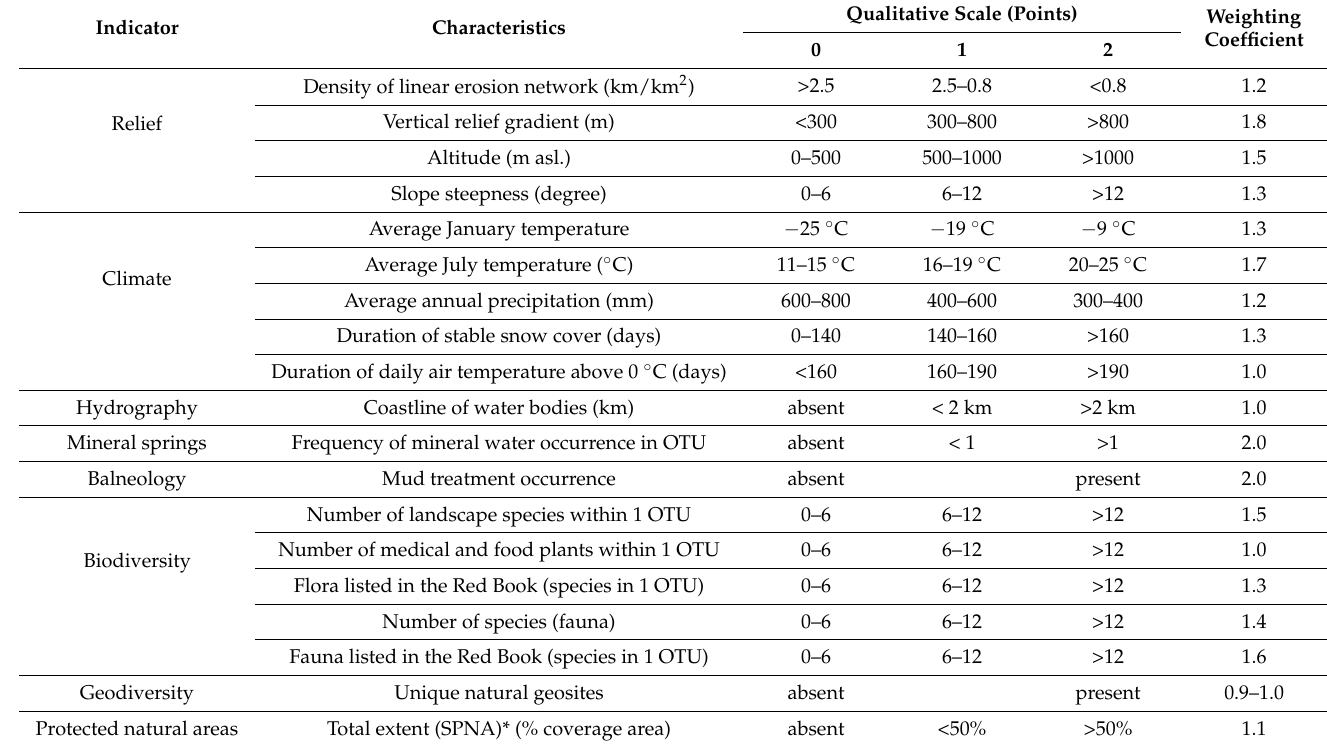
Table 1. Indicators of the territorial evaluation of the geo-/ecotourism and recreation potential in the southern Altai area eastern